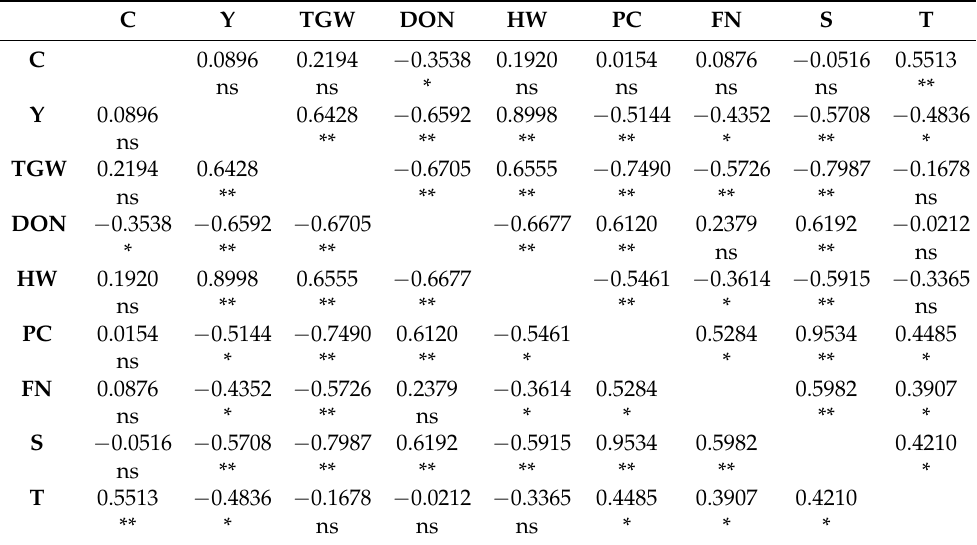
Table 9. Pearson product moment correlations between each pair of variables (2 years